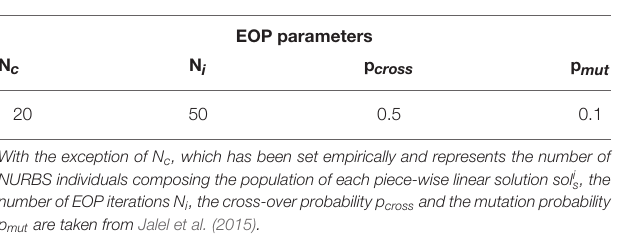
TABLE 1 | Parameters used for the